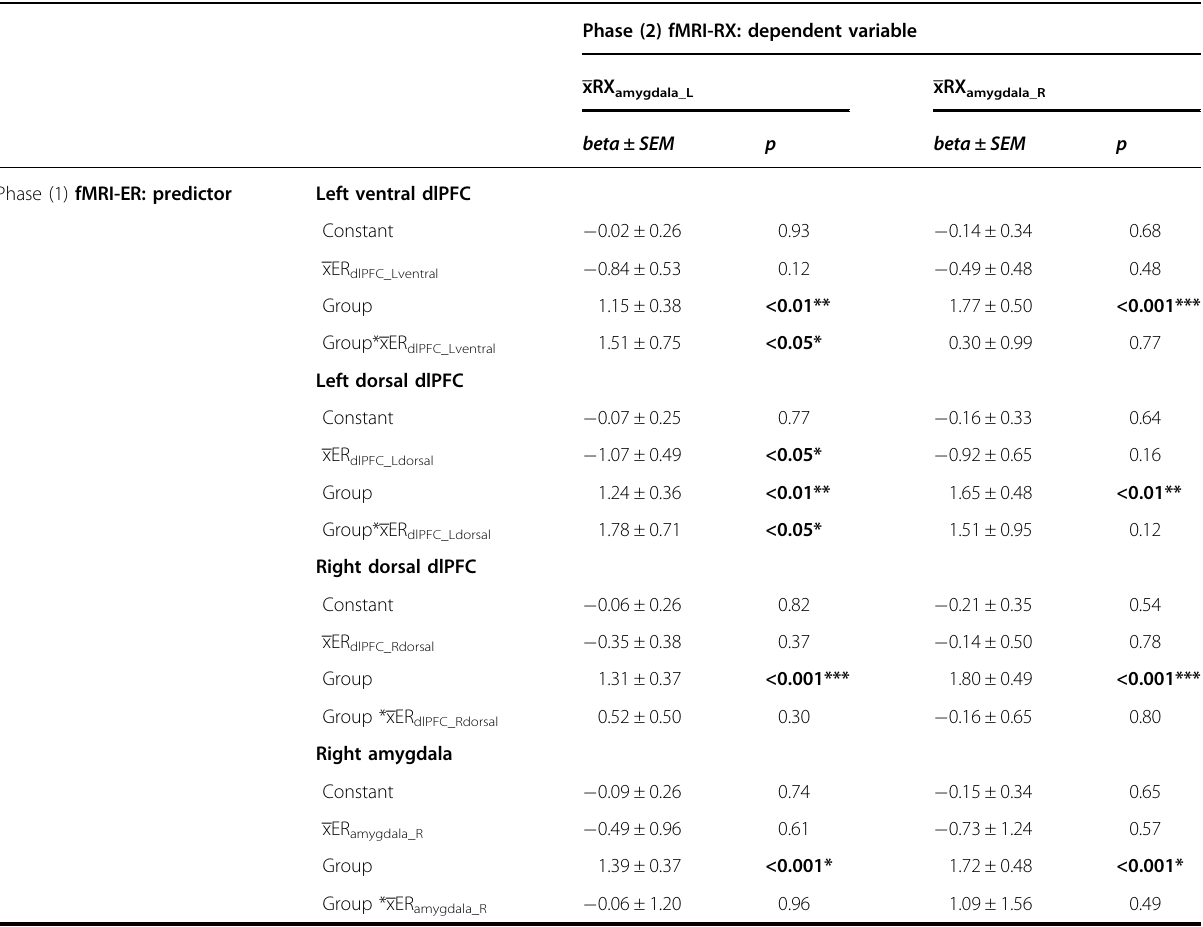
Table 3 Results of regression analyses: Prediction of phase (2) fMRI-RX amygdala activation by phase (1) fMRI-ER dlPFC activation and, as a control analysis, by phase (1) fMRI-ER amygdala activation, moderated by group.